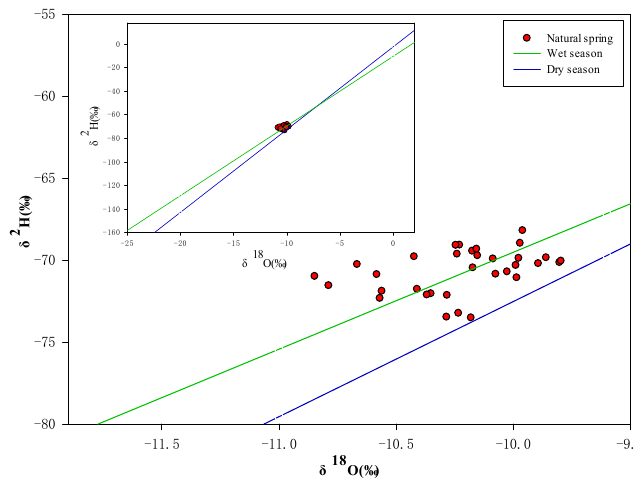
Figure 7. ( a ) Relationship between δ 2 H and δ 18 O of precipitation, stem runoff, throughfall, surface runoff, soil water and the natural spring. The black line shows the rainstorm precipitation process line where δ 2 H = 6.1 δ 18 O − 7.0 ( R 2 = 0.98, N = 36); ( b ) The variations of δ 2 H and δ 18 O values of soil water in the study area.